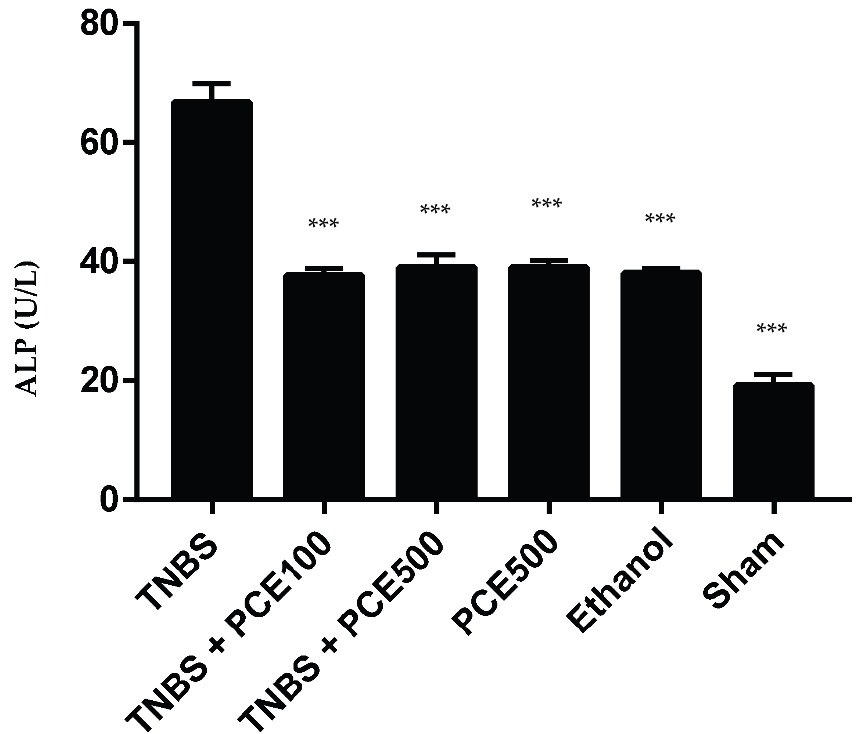
Figure 4. Effect of PCE treatment on total ALP concentration in the IBD. The results are represented as mean ± SD [ n (TNBS + PCE100) = 10; n (TNBS + PCE500) = 10; n (PCE) = 10; n (TNBS) = 6; n (Ethanol) = 5; n (Sham) = 5; *** p < 0.001 compared with TNBS group, one ‐ way ANOVA followed by